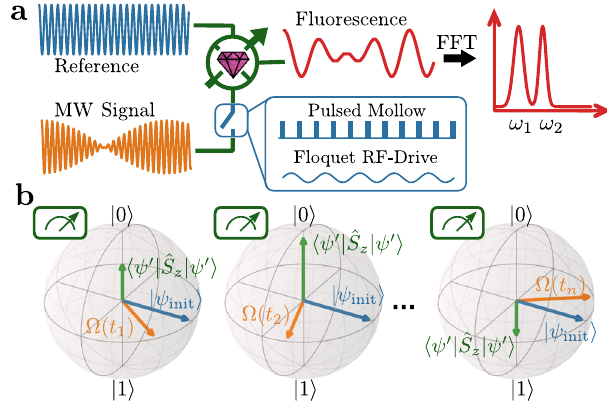
Fig. 1 Microwave heterodyne detection principle and its realization with a quantum sensor. a Heterodyne detection of a multimode microwave frequency fi eld relative to an external frequency reference using the NV center sensor as a mixer. The interaction with the signal is controlled by application of dressing fi elds. We benchmark two techniques: (1) pulsed Mollow absorption using dynamical decoupling sequence and (2) Floquet dynamics under strong RF-driving. The demodulated signal leads to high spectral resolution. b Heterodyne detection by creating the same initial (cid:5) (cid:6) (cid:5) state ψ (blue) from a coherent external MW-source between init sequential measurements. A long coherent signal Ω ( t ) (orange) is stroboscopically observed in the rotating frames. Finally, the z-projection (cid:5) (cid:6) (cid:5) (green) of ψ 0 , the fi nal state after evolution under Ω , is measured, allowing to reconstruct the relative microwave